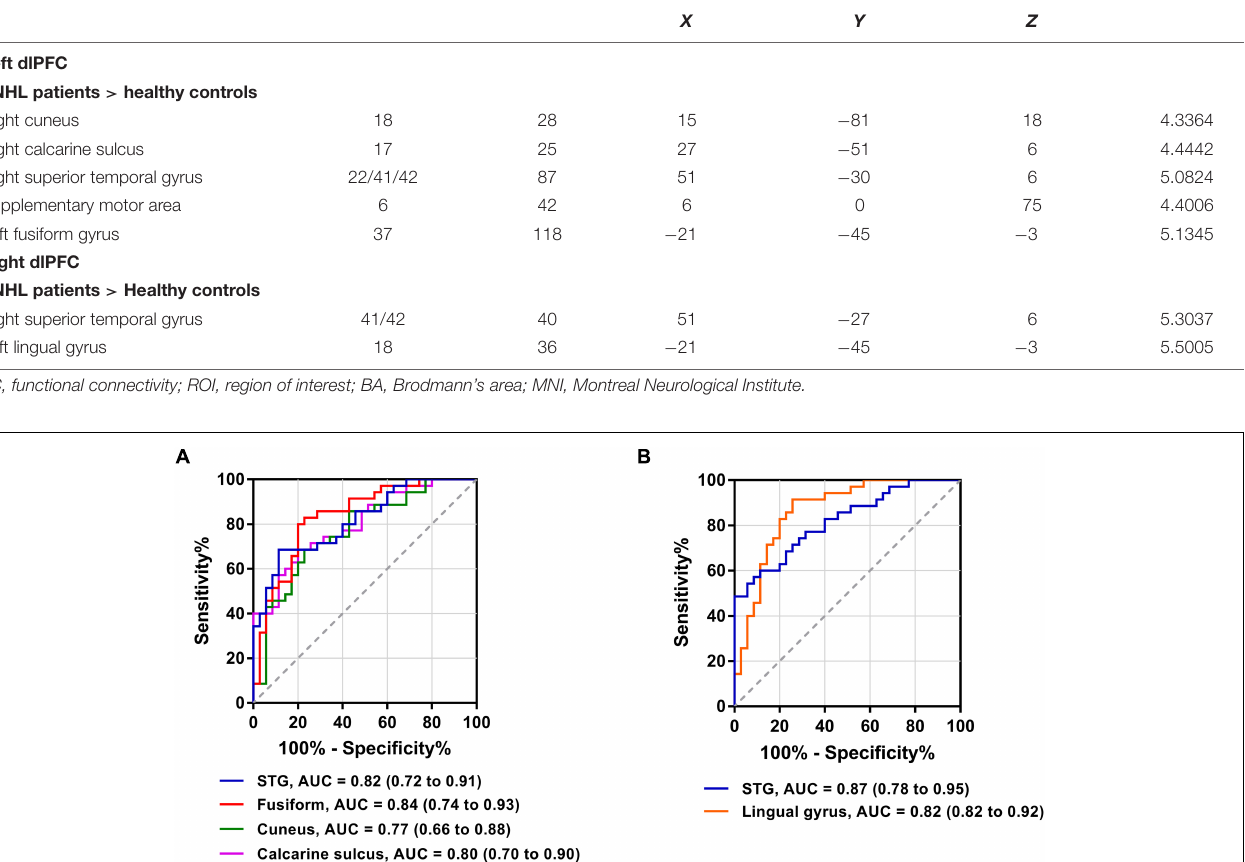
TABLE 4 | Differences in FC in patients with SNHL compared with healthy controls when the ROI was set at the left and right dlPFC. Brain region BA Voxel size Peak MNI coordinates (mm)